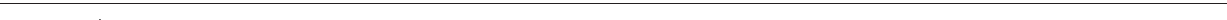
FIGURE 3 | as the AAV9-IL9 + CP group. Mice were injected with AAV9-IL9 vectors by tail vein injections without CP injection as the AAV9-IL9 group. Mice were injected with AAV9 empty vectors by tail vein injections without CP injection as the AAV9 group. Mice were induced with a single intraperitoneal injection of CP as the CP group. Mice were given a single intraperitoneal injection of saline as the vehicle group. Magnification: × 40. (B) The level of IL-9 in the supernatant of THP-1 cells stimulated with CP (100 µ mol/L) for 8h. * P < 0.05 vs. the vehicle group. (C) The mRNA level of IL-9 in THP-1 cells stimulated with CP (100 µ mol/L) for 8h. Dot plots showed the corresponding quantification of mRNA level and fold change. *** P < 0.001 vs. the vehicle group. (D) The levels of IL-9 in the supernatant of RAW264.7 cells with CP (100 µ mol/L) administration. ** P < 0.01 vs. the vehicle group. (E) The mRNA levels of IL-9 in RAW264.7 cells with CP (100 µ mol/L) administration. Dot plots showed the corresponding quantification of mRNA level and fold change. * P < 0.05 vs. the vehicle group. (F) The level of tumor necrosis factor- α (TNF- α ) in the supernatant of THP-1 cells stimulated with CP (100 µ mol/L) and treated with 100ng/ml recombinant IL-9. * P < 0.05, *** P < 0.001 vs. the vehicle group; # P < 0.05 vs. the CP-treated group. (G) The level of IL-6 in the supernatant of THP-1 cells stimulated with CP (100 µ mol/L) and treated with 100ng/ml recombinant IL-9. ** P < 0.01 vs. the vehicle group; ## P < 0.01 vs. the CP-treated group. (H) The level of TNF- α in the supernatant of RAW264.7 cells stimulated with CP (100 µ mol/L) and treated with 100ng/ml recombinant IL-9. *** P < 0.001 vs. the vehicle group; ## P < 0.01 vs. the CP-treated group. (I) The level of IL-6 in the supernatant of RAW264.7 cells stimulated with CP (100 µ mol/L) and treated with 100ng/ml recombinant IL-9. ** P < 0.01 vs. the vehicle group; ### P < 0.001vs. the CP-treated